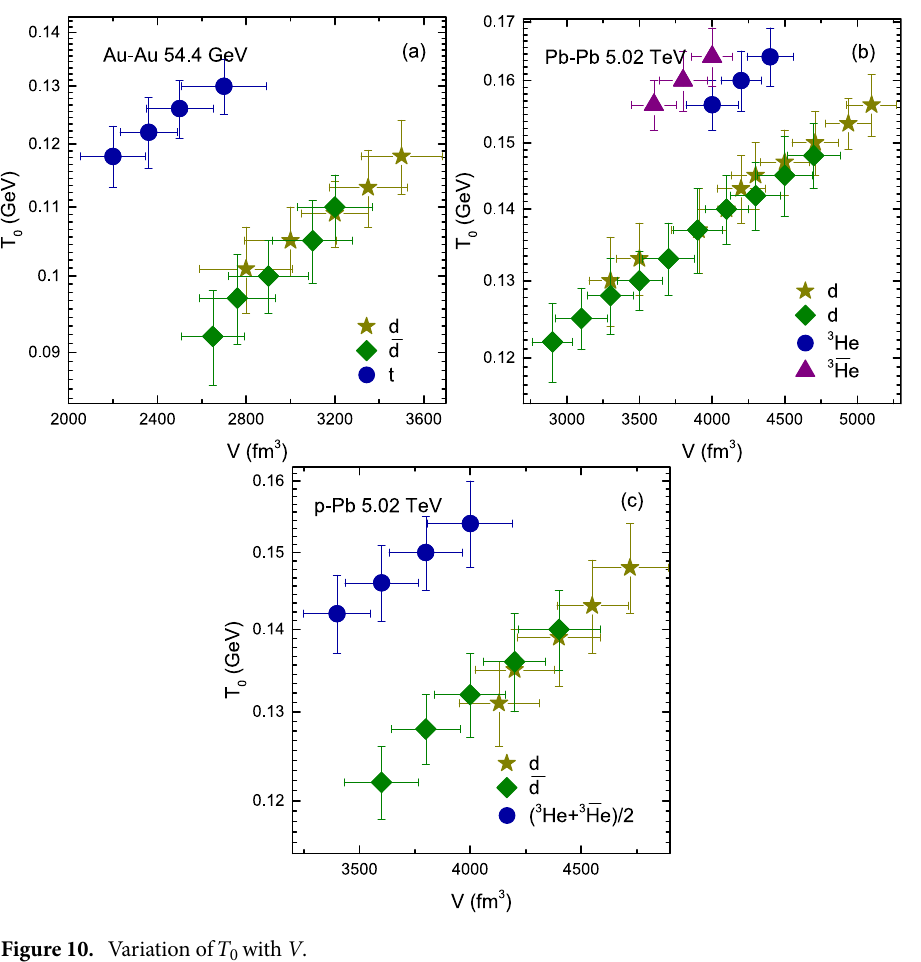
Figure 10. Variation of T 0 with V